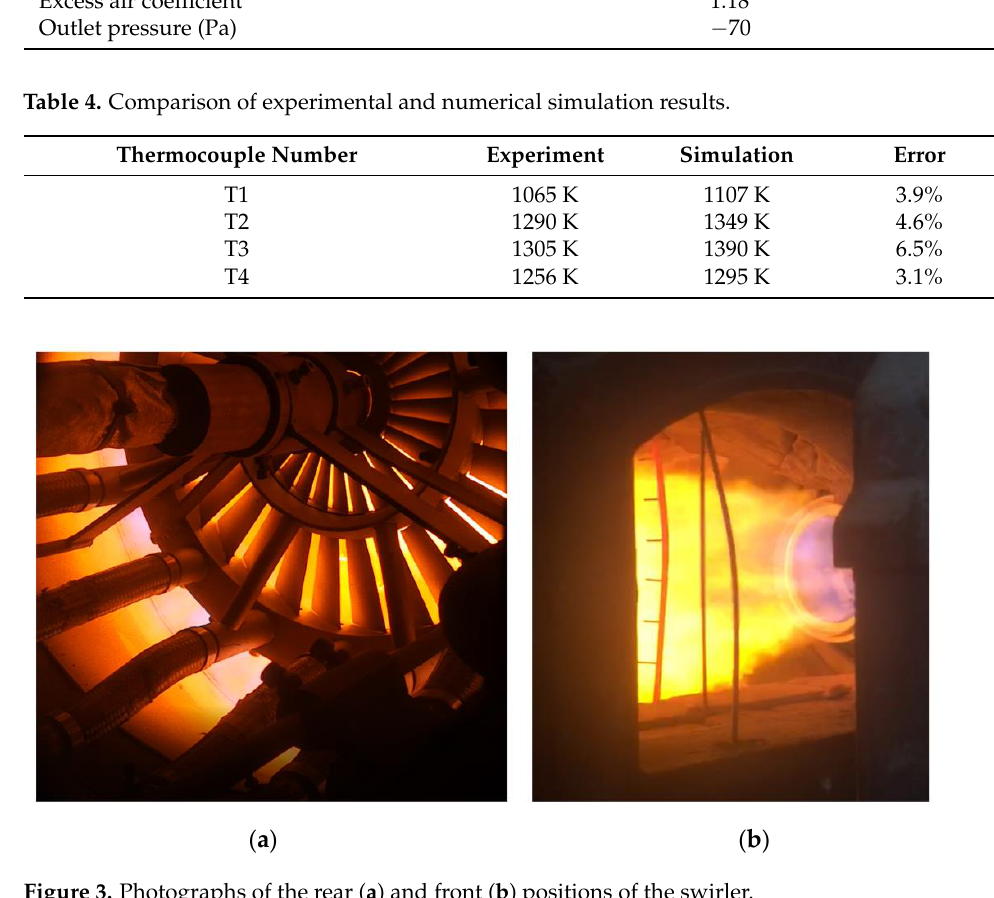
Table 3. Parameters for the experiments.